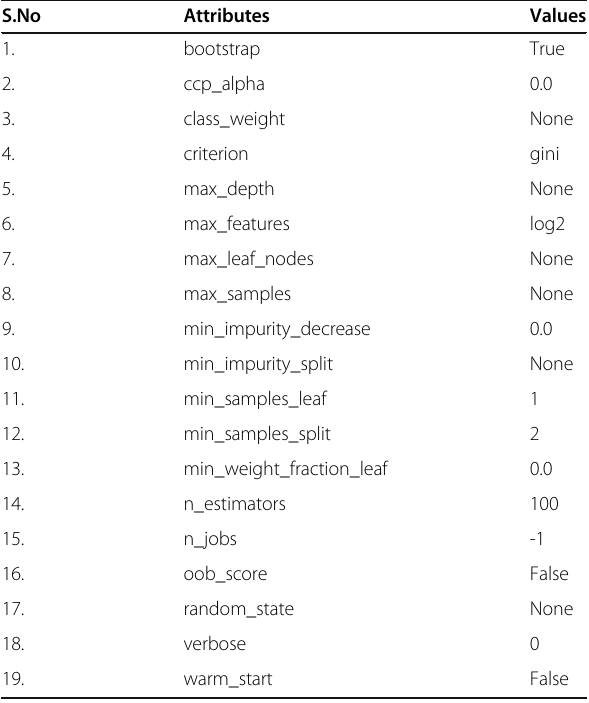
Table 3 A list of optimal values for the classifier as a result